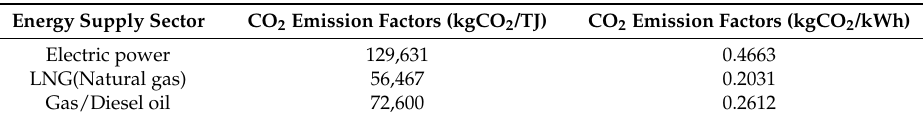
Table 5. CO 2 emission factors according to energy supply